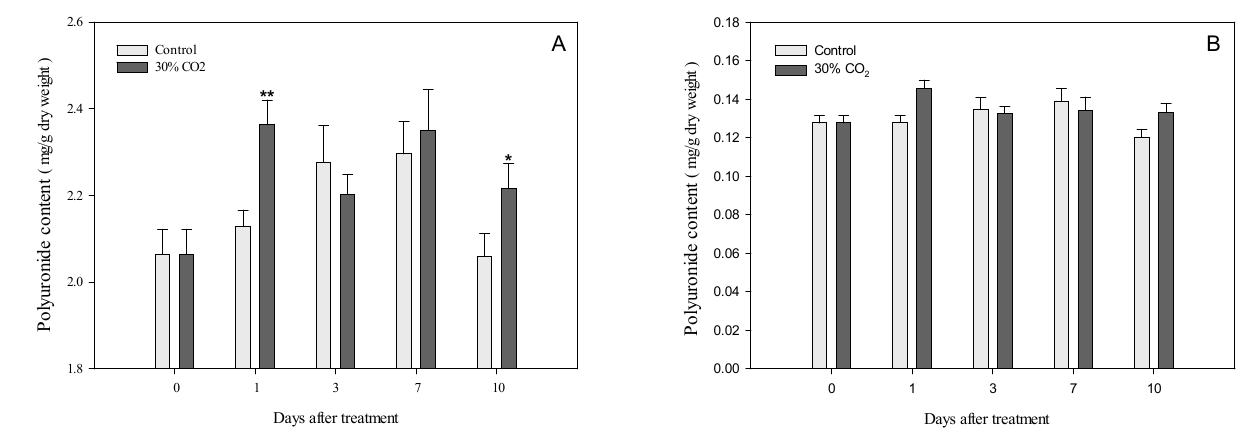
Figure 3. Polyuronide contents of crude cell wall material ( A ) and water-soluble pectin ( B ) from strawberry fruits treated with 30% CO 2 for 3 h, as well as control fruits. * p < 0.05; ** p < 0.01.